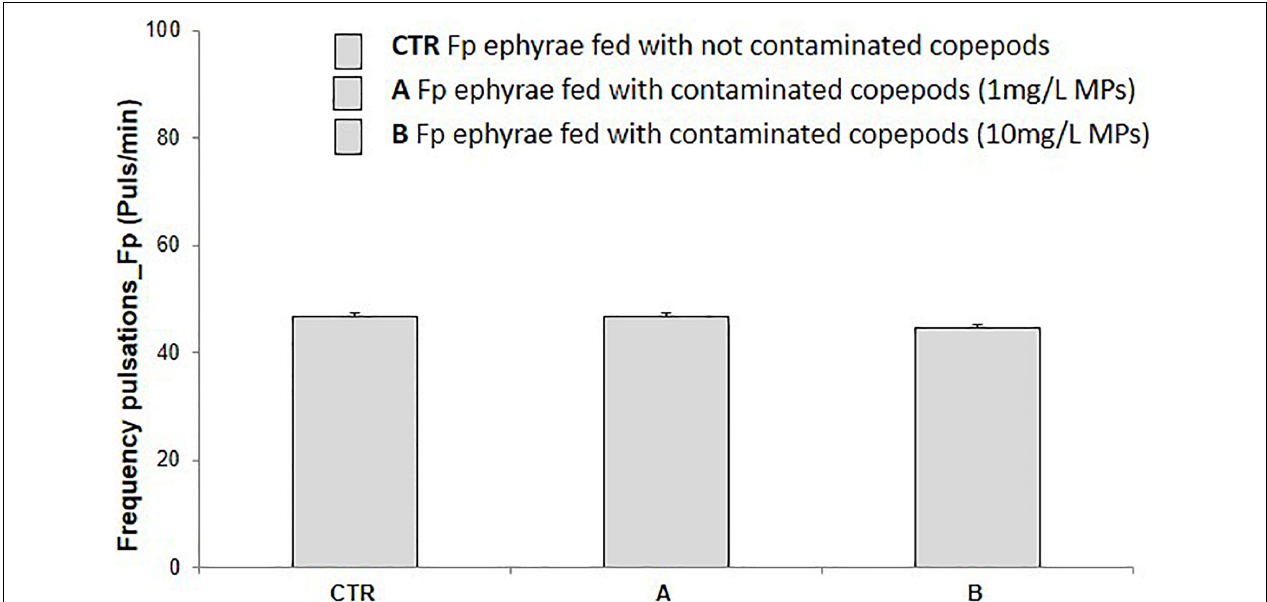
FIGURE 2 | Pulsation frequency (pulse/min) recorded for Aurelia sp. ephyrae after feeding uncontaminated T. fulvus nauplii (CTR) and nauplii contaminated with 1 mg/L (A) and 10 mg/L (B) of polyethylene MPs. (M ± SE, n = 3). No significant difference was observed between treatments and controls in any of the tests (A,B).